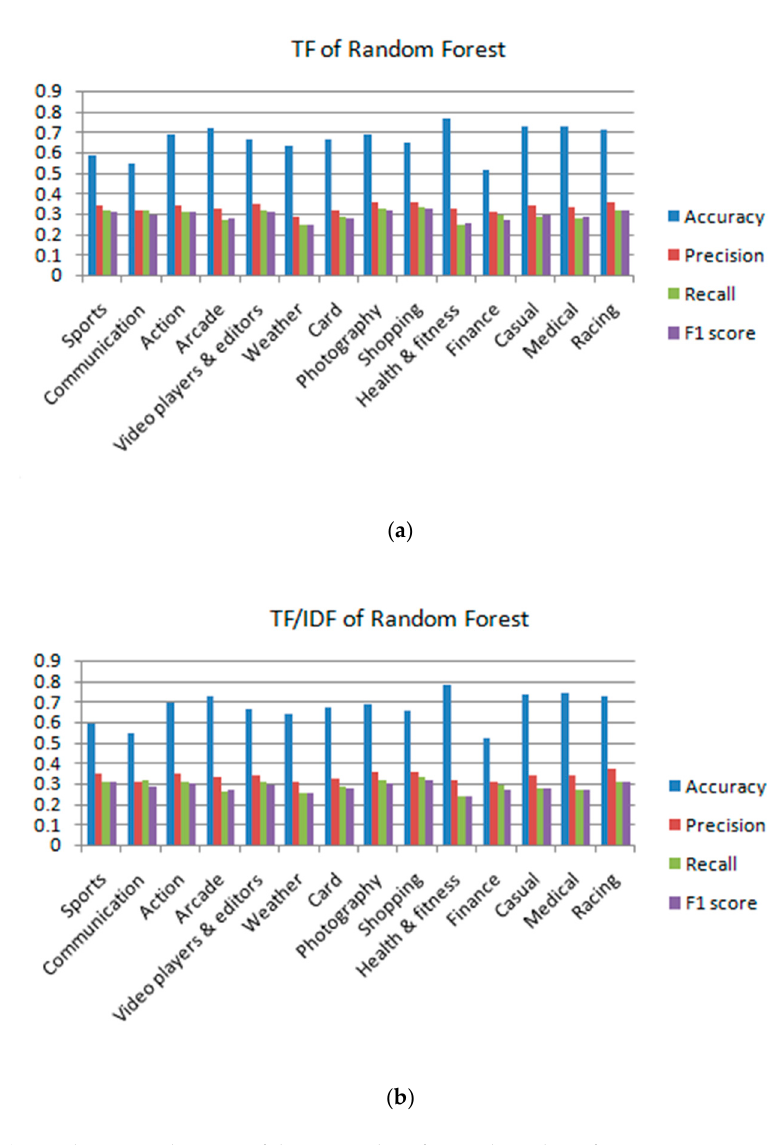
Figure 4. ( a ) Bar-chart visualization of the TF random forest algorithm after preprocessing; ( b ) bar-chart visualization of the TF/IDF random forest algorithm after preprocessing.